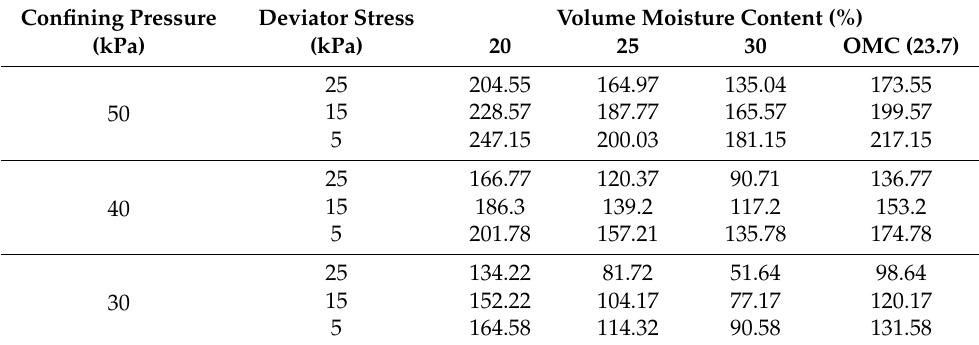
Table 3. Resilient modulus(kPa) of modified soil at different moisture